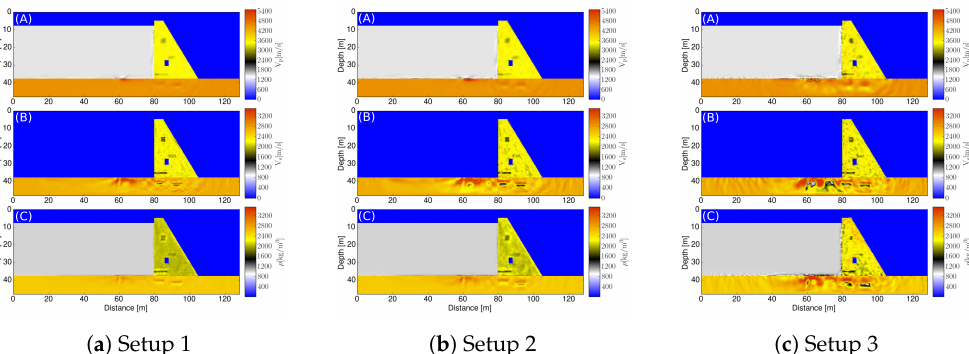
Figure 7. FWI model for acquisition setups with ( A ) V p distribution ( B ) V s distribution (note that shear waves only travel through solids) and ( C ) ρ distribution.